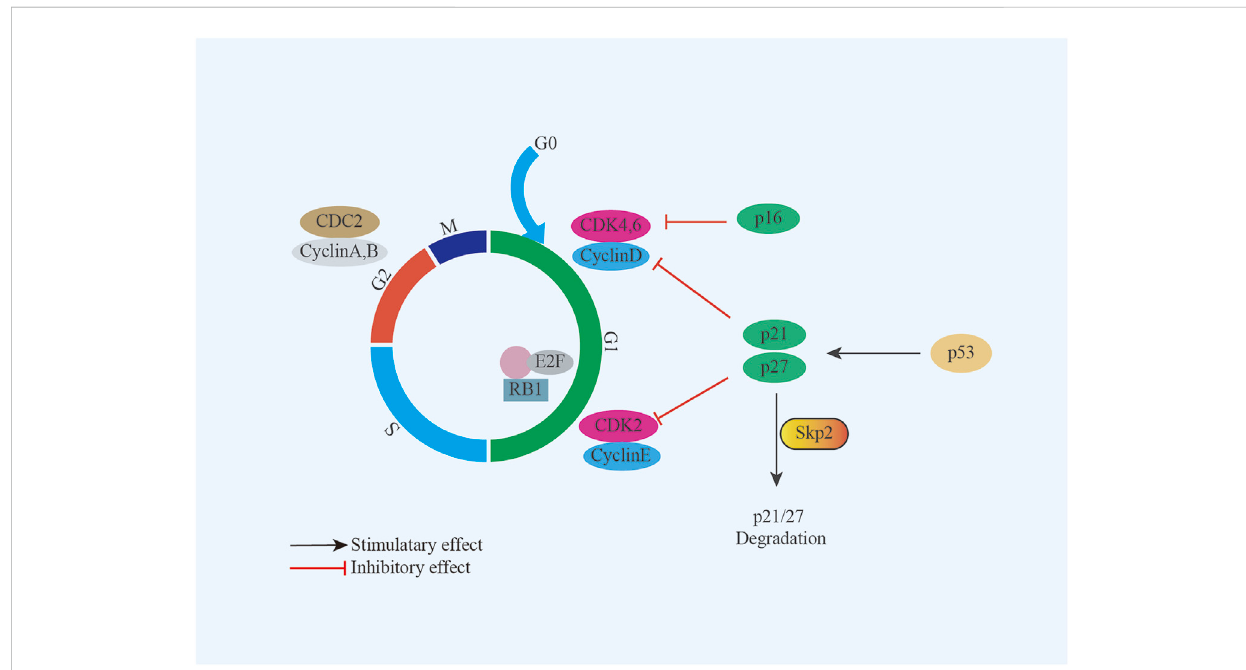
FIGURE 1 Model summarizing the role of Skp2 and p16 in UPS/MFS. TP53 de fi ciency renders UPS/MFS cells dependent on Skp2 which survives sarcoma cells by degrading p21 and p27; p16 is an important regulator in cell cycle through interaction with cyclin-dependent kinases